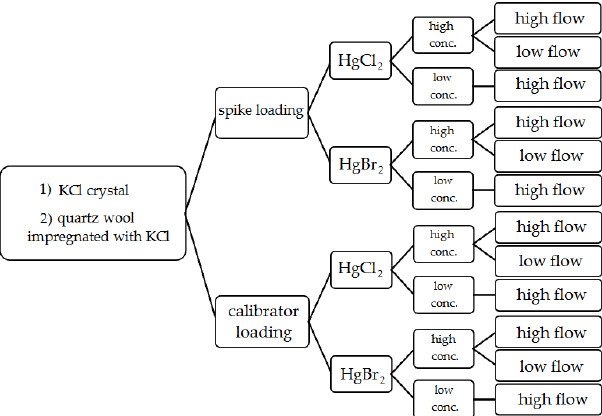
Figure 2. Variations of performed experimental conditions for Hg 2 + stability on KCl sorbent traps during exposure in ambient